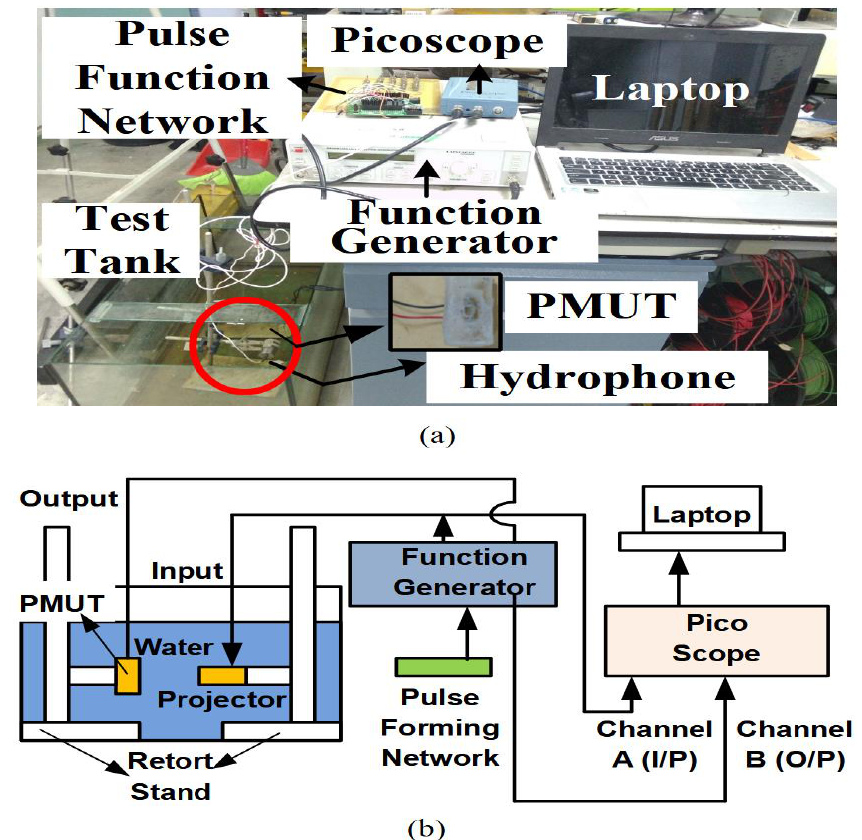
Figure 5. Pulse–echo experimental setup: ( a ) experimental field-work setup; ( b ) schematic drawing of the pulse–echo experimental setup.